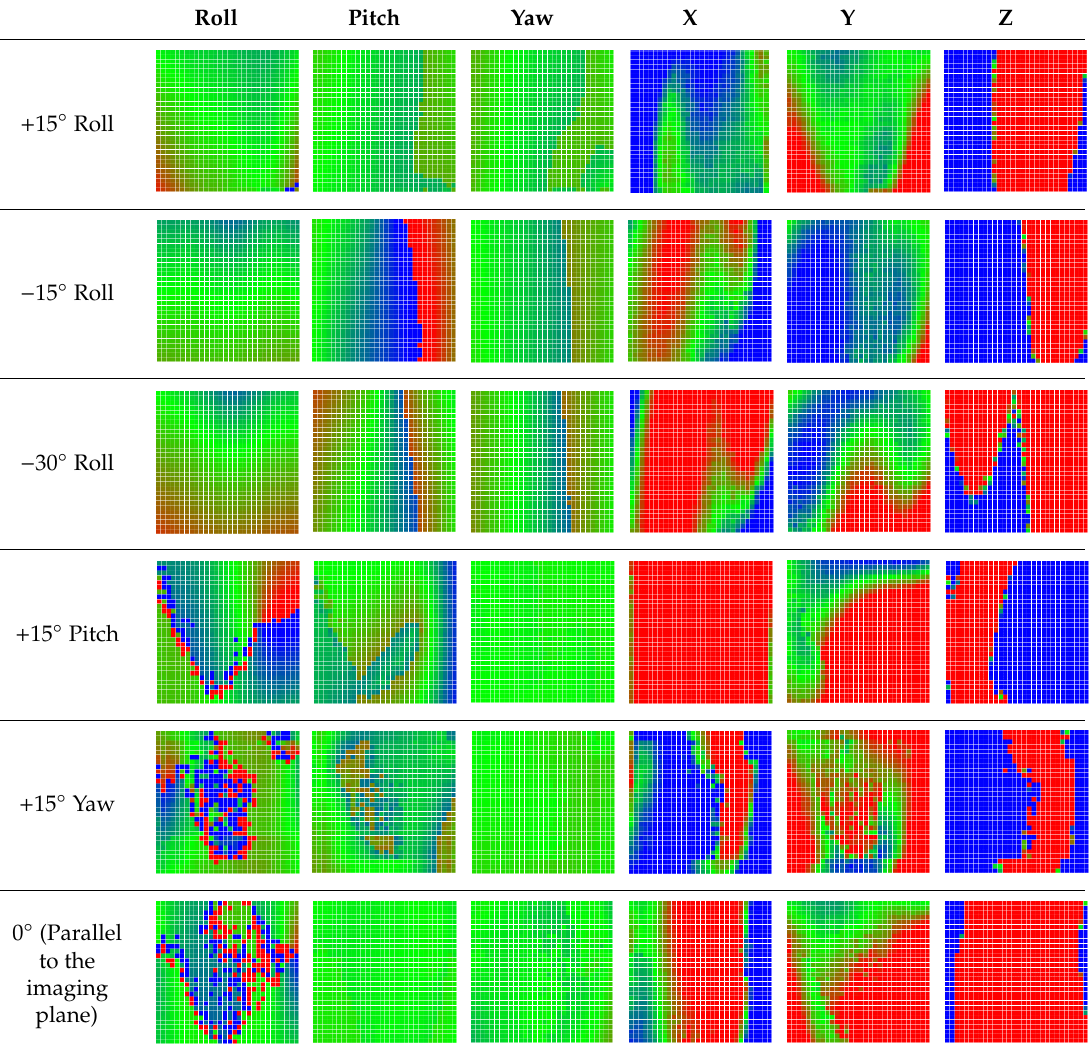
Table 3. Results from the benchmark for the 2D Aruco grid board, deviations along each detected parameter of the tags for various positions of the grid board in the camera field of view (FOV). Roll